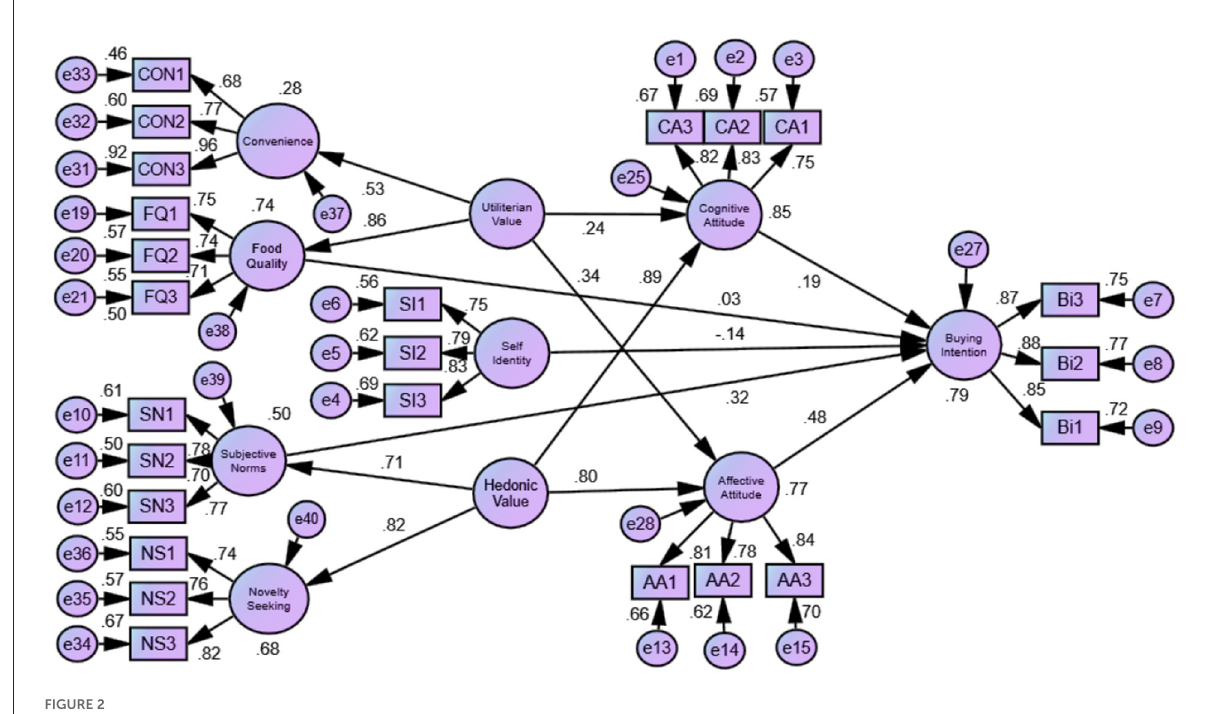
FIGURE2 Structural model.